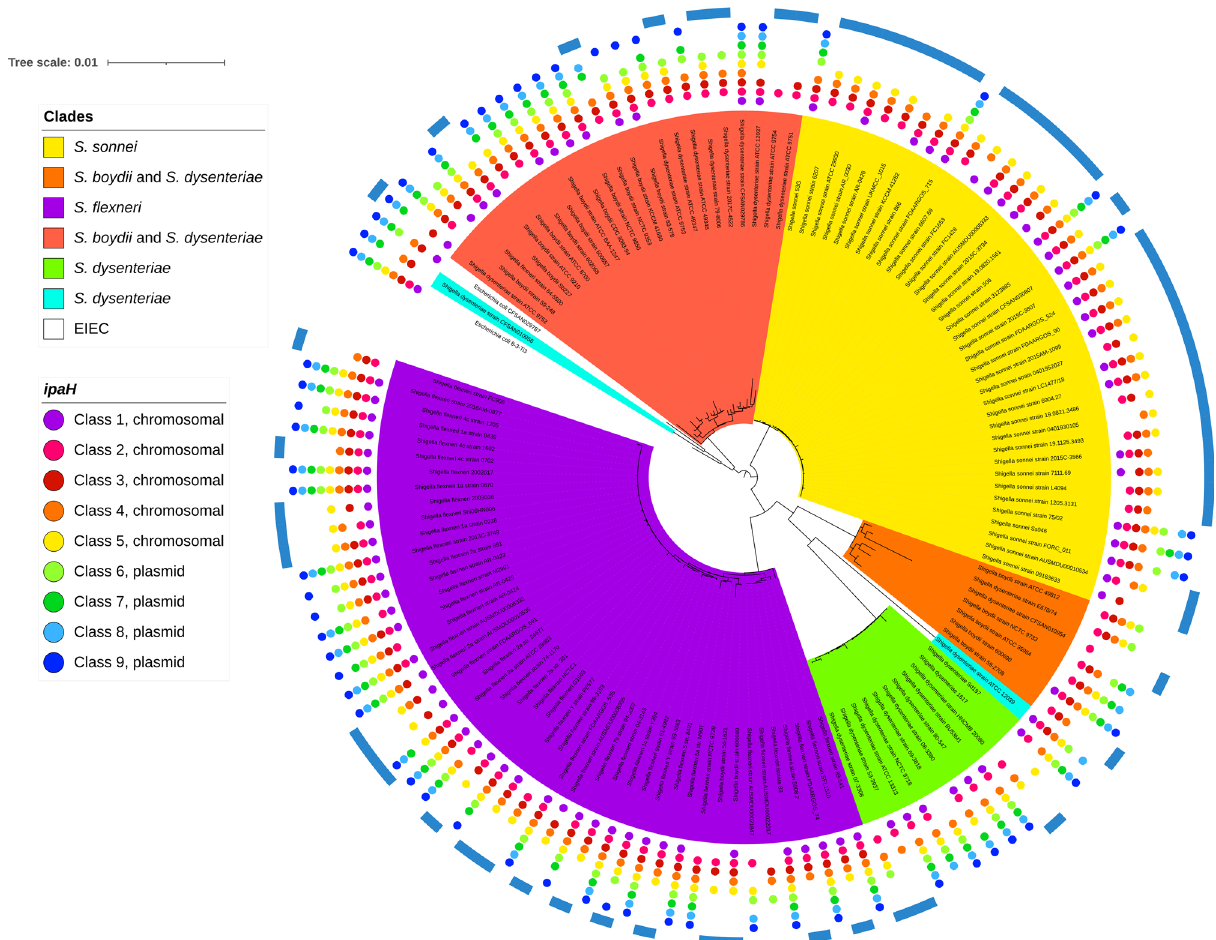
Figure 3. Phyletic patterns of the ipaH genes in Shigella and EIEC. The coloring of the unrooted tree reflects major Shigella clades that putatively evolved from different non-pathogenic E. coli ; two distant Shigella strains are shown in blue, the EIEC strains are shown in white. The presence of the ipaH genes is shown by dots whose color reflects the ipaH class (see the legend). The genes in classes #1–5 are located in chromosomes; the genes in classes #6–9, in plasmids. The genomes marked by the external blue arcs do not contain the T3SS